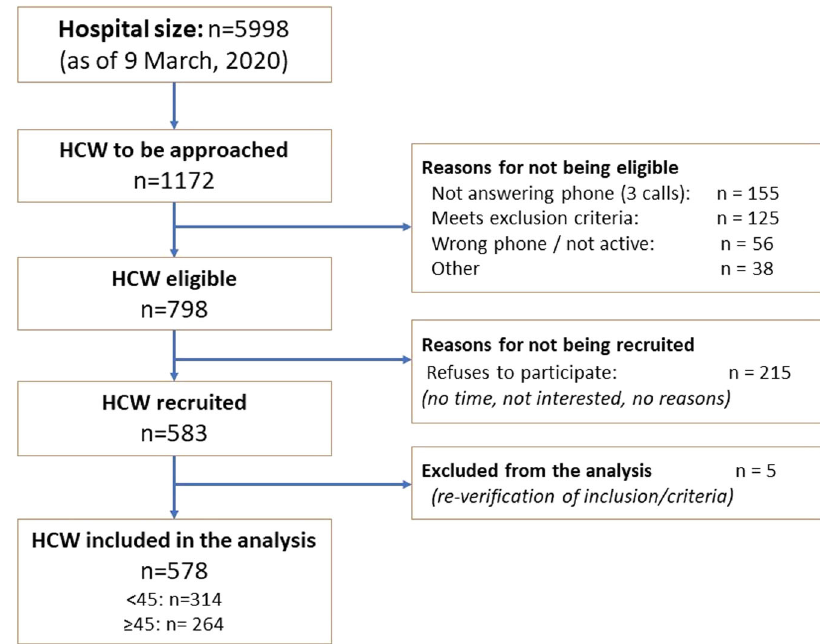
Fig. 1 Study participant fl